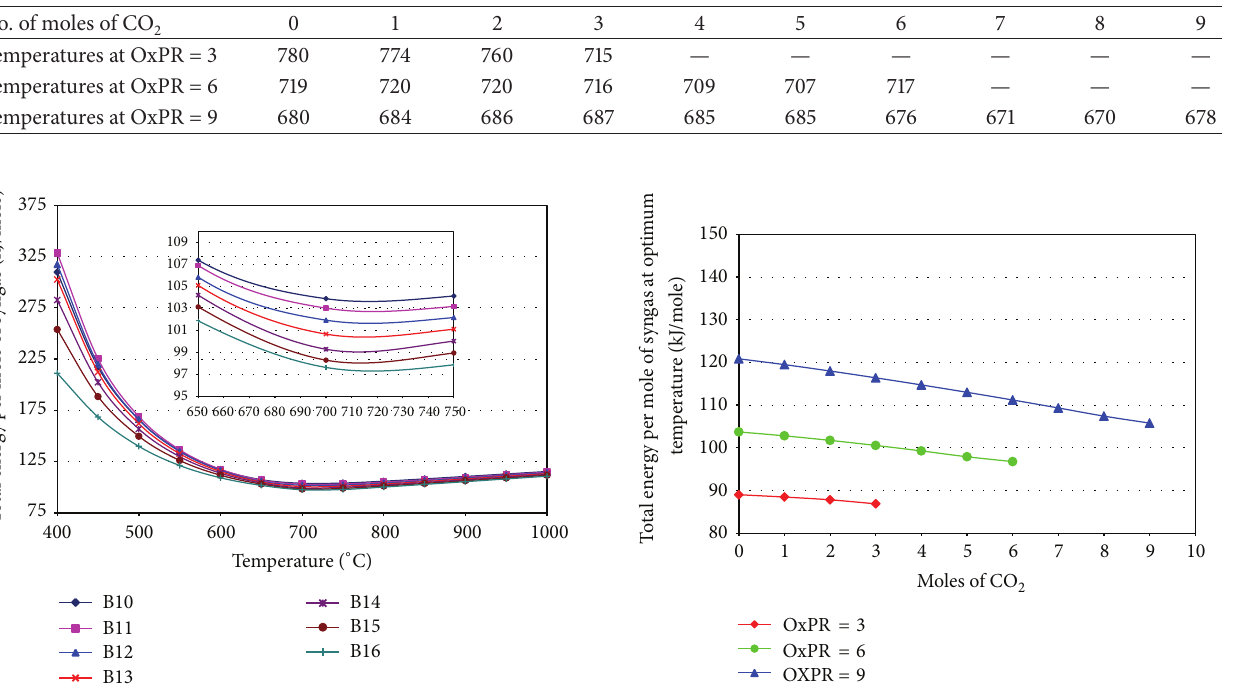
Table 2: Optimum temperatures in combined reforming of propane.